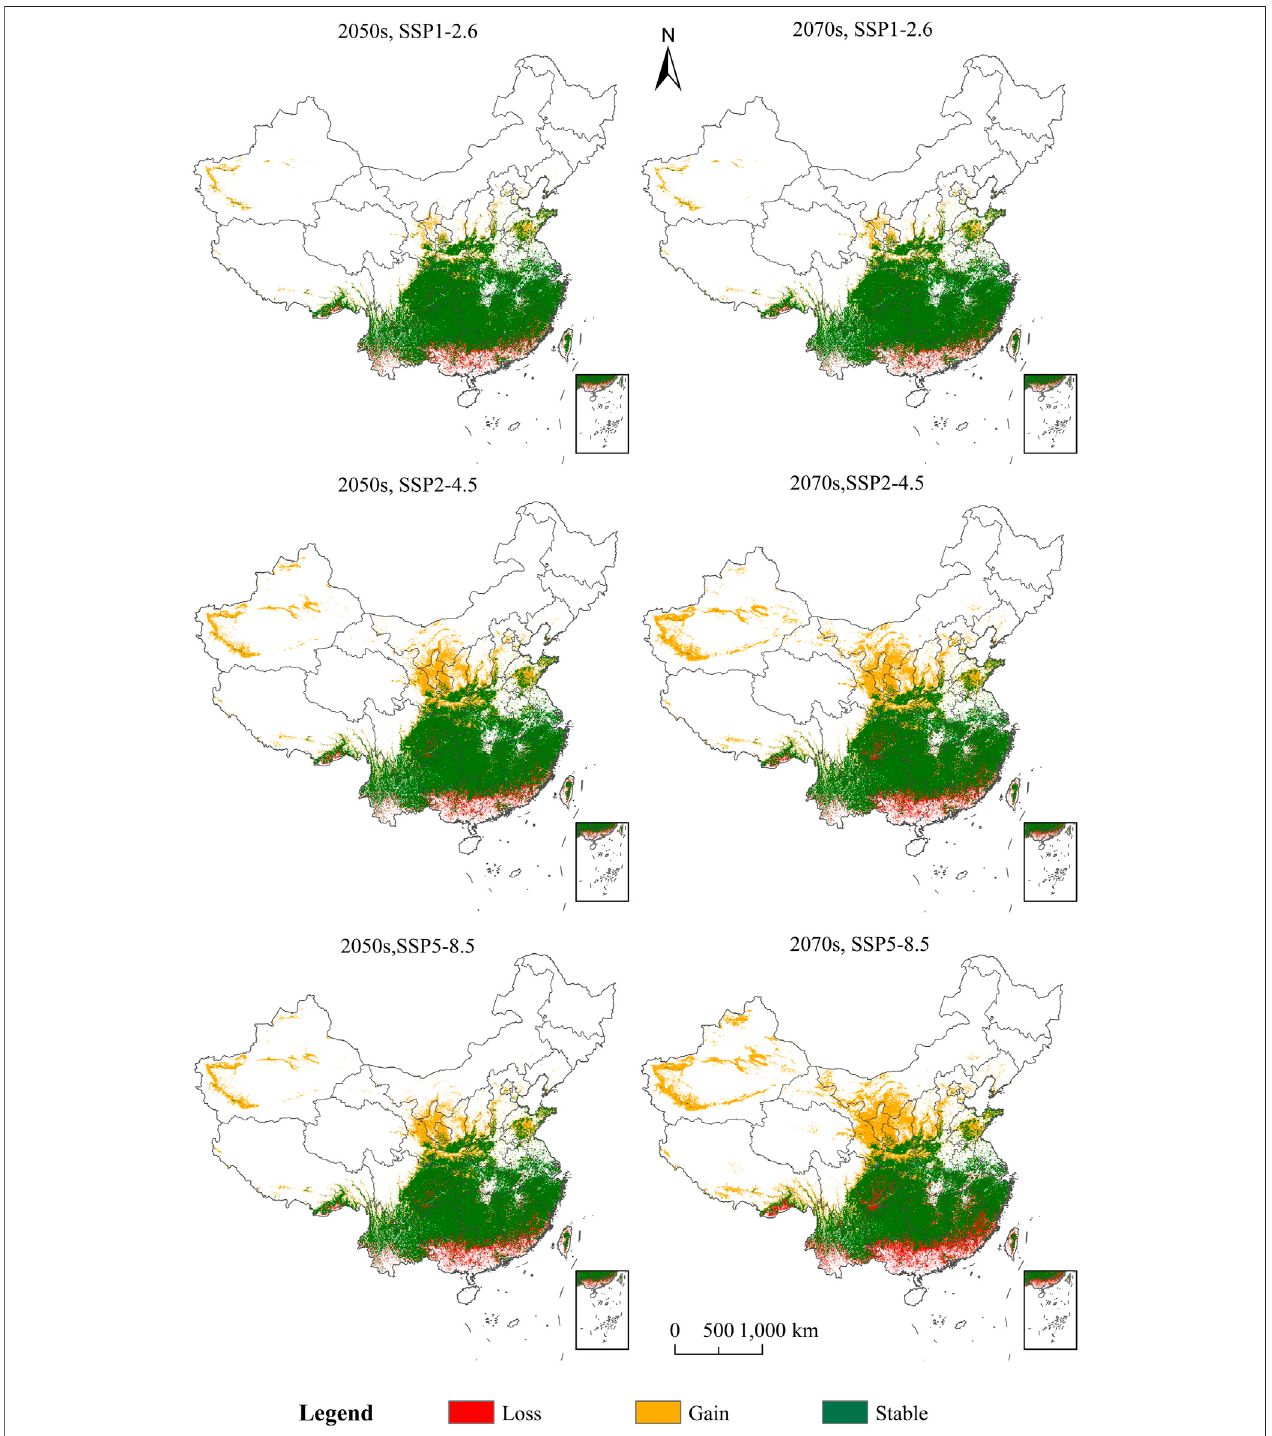
FIGURE 4 | Changes in the potential spatial distribution of Cremastra appendiculata under scenarios of climate change.